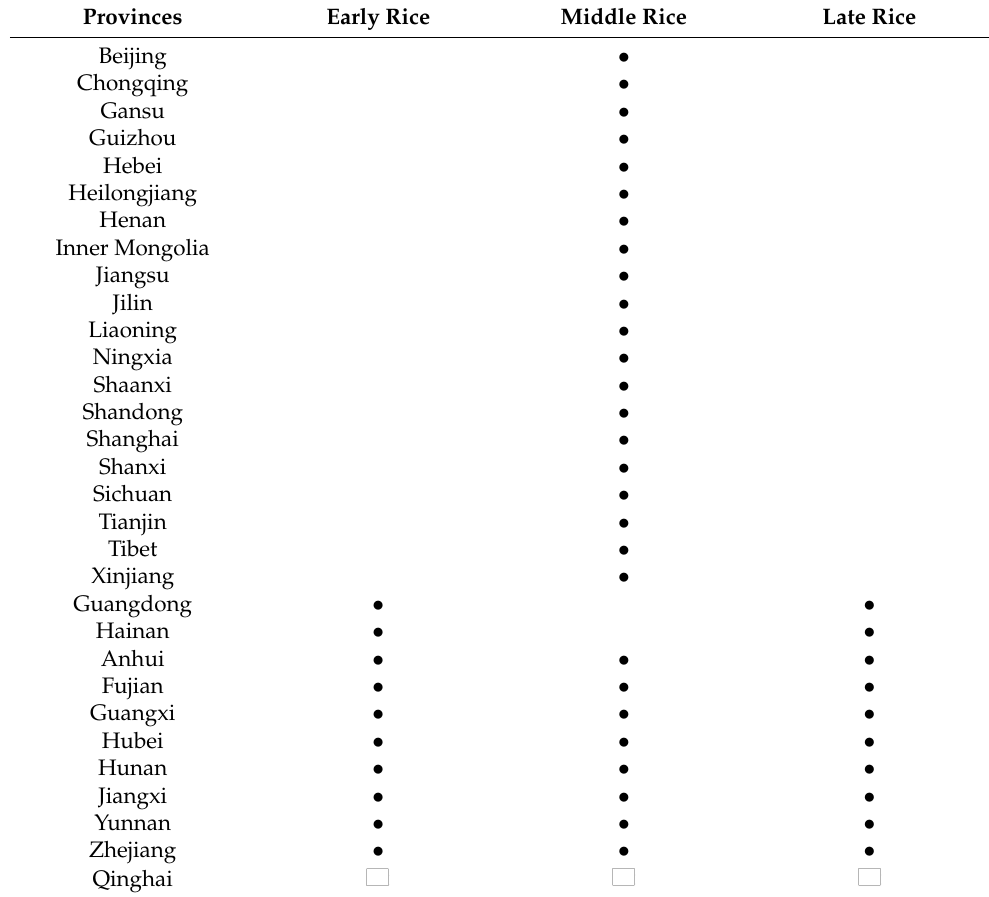
Table 1. Types of rice production in different provinces in China